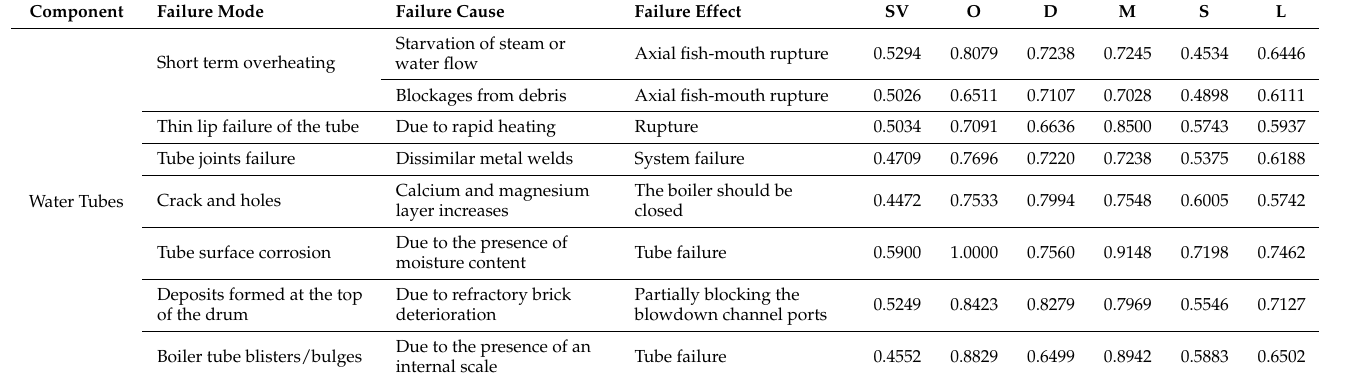
Table 10. Normalized decision matrix for